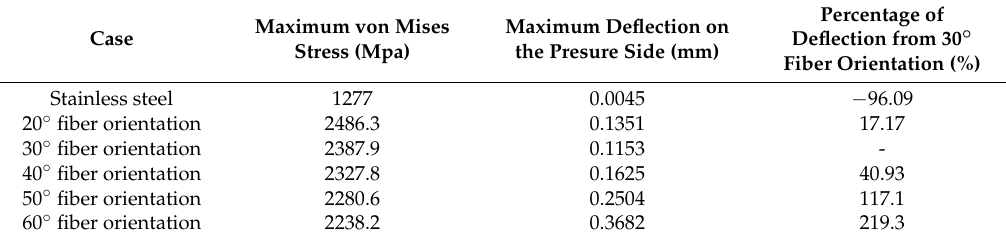
Table 4. Maxiumu von Mises stress and tip deflection.